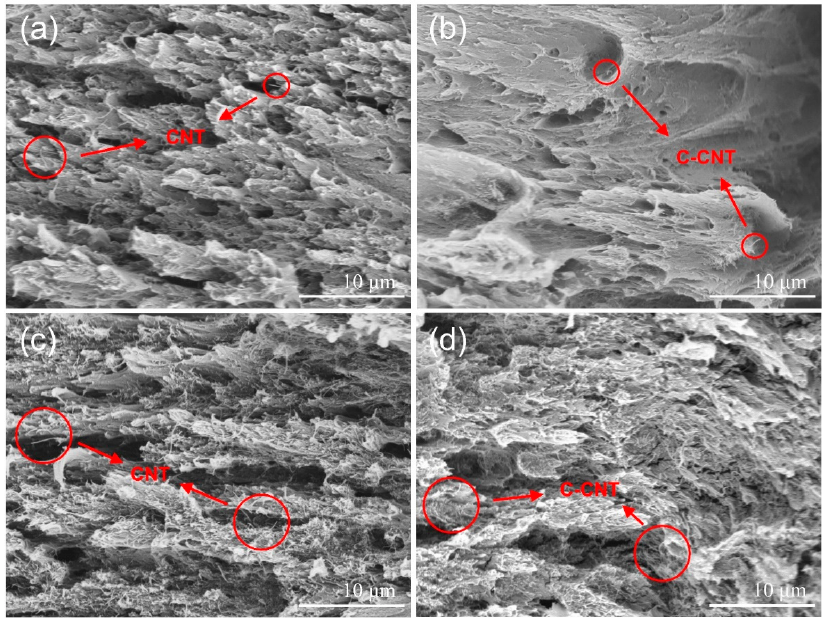
Figure 9. SEM cross-sectional images of ( a ) 1 wt.% CNT/PI film, ( b ) 1 wt.% C-CNT/PI film, ( c ) 9 wt.% CNT/PI film, ( d ) 9 wt.% C-CNT/PI film. 3.3. Thermal Properties of CNT/PI and C-CNT/PI Films The thermal behaviors of PI films with various CNT and C-CNT contents were ex- amined by TGA to evaluate the thermal stability, and the results are shown in Figure 10. The thermal decomposition of the PI film started at about 500 °C [55]. It can be seen from Table 5 that the 5 wt.% loss temperature of the pure PI film was only 551.63 °C. After mixing with CNT or C-CNT, the 5 wt.% loss temperature of the films was significantly increased and reached the highest value when the content was 7 wt.%. With the further increase in the content of CNT or C-CNT, the 5 wt.% loss temperature of the films de- creased. This behavior may be due to the fact that excessive fillers tend to agglomerate and hinder heat transfer, generating high-temperature spots, thus affecting the continued improvement of thermal stability. At the same content, C-CNT showed a better effect of improving the thermal stability of the film than CNT, and the 5 wt.% loss temperature could reach up to 595.49 °C (7 wt.% C-CNT/PI film), which may be related to the high thermal stability of C-CNT and good filler-polymer affinity [56]. Moreover, the improved thermal resistance of PI films after mixing with CNT and C-CNT also led to a higher re- sidual rate at 800 °C, from 49.93% (pure PI film) to 59.61% (9 wt.% C-CNT/PI film).